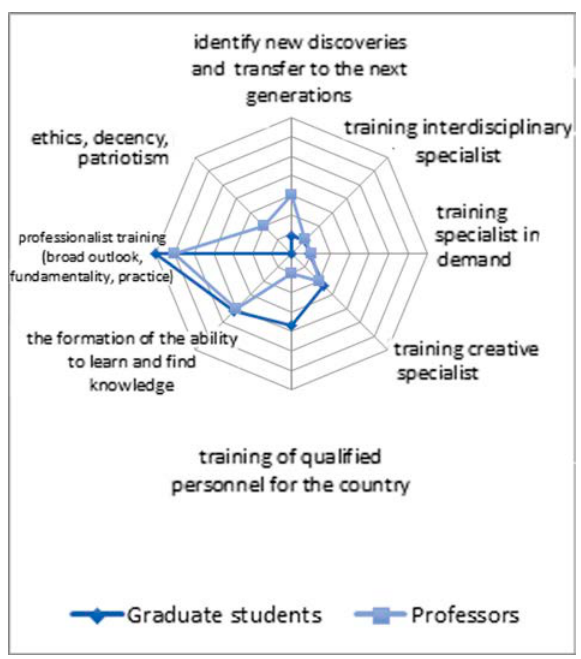
Fig. 8. Respondents' opinions on the goals of higher education.